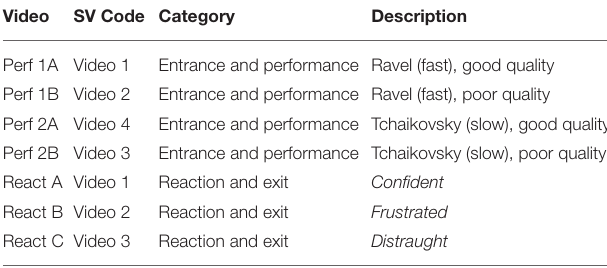
TABLE 2 | Summary of the video footage